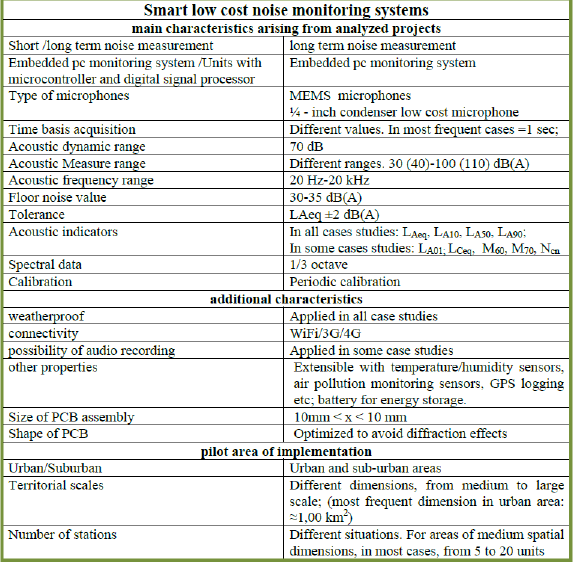
Figure 4: Analysis of the state of the art about smart low-cost noise monitoring